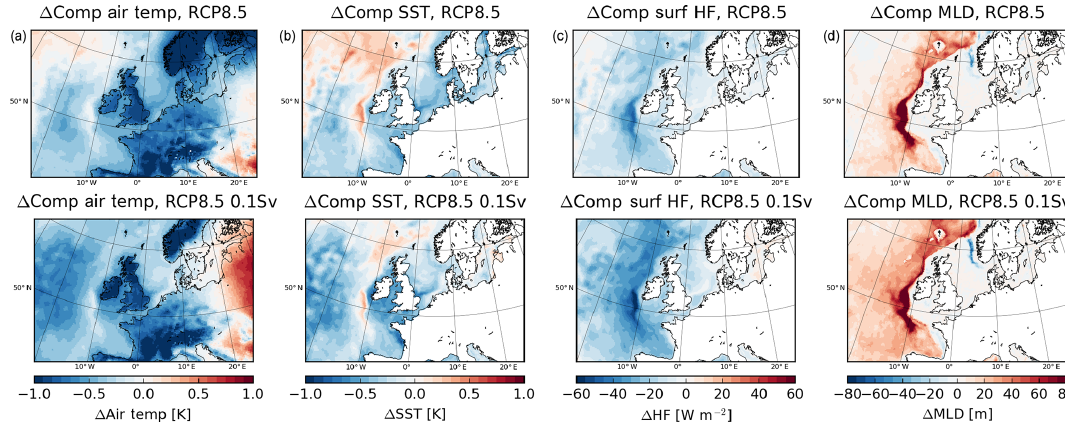
Figure A4. Differences between positive and negative composites of 2m air temperature (a) , sea surface temperature (b) , downward surface heat flux (c) and MLD (d) during the shallow-ML regime (2101–2150) for experiments without (E0, upper row) and with (E010, lower row) GIS meltwater discharge. Composites are calculated the same way as for Fig. 13.